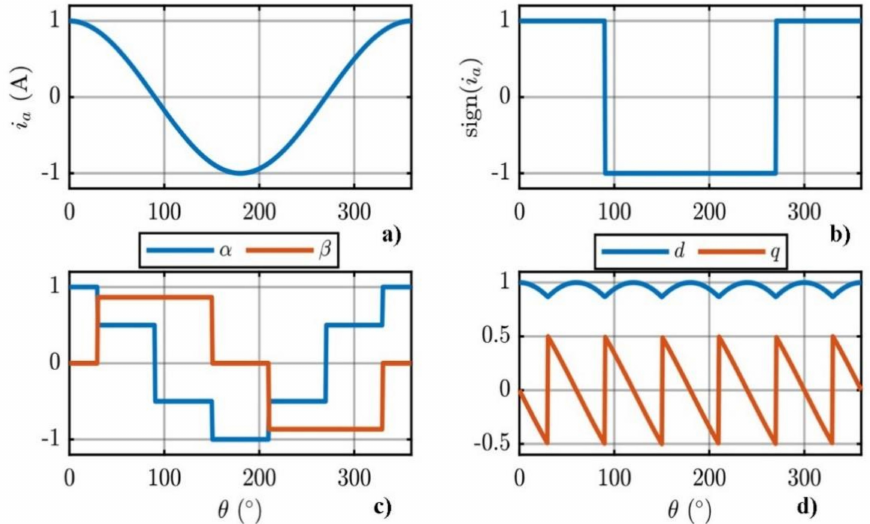
Figure 16. Dead time effect modeling in the stationary reference frame and in the synchronous reference frame. ( a ) Top left: current of phase a. ( b ) Top right: sign ( i a ) . ( c ) Bottom left: sign ( i a ) function in per unit in the stationary ( α , β ) frame. ( d ) Bottom right: sign ( i a ) function per unit in the rotating (d,q) frame, synchronous with the phase a